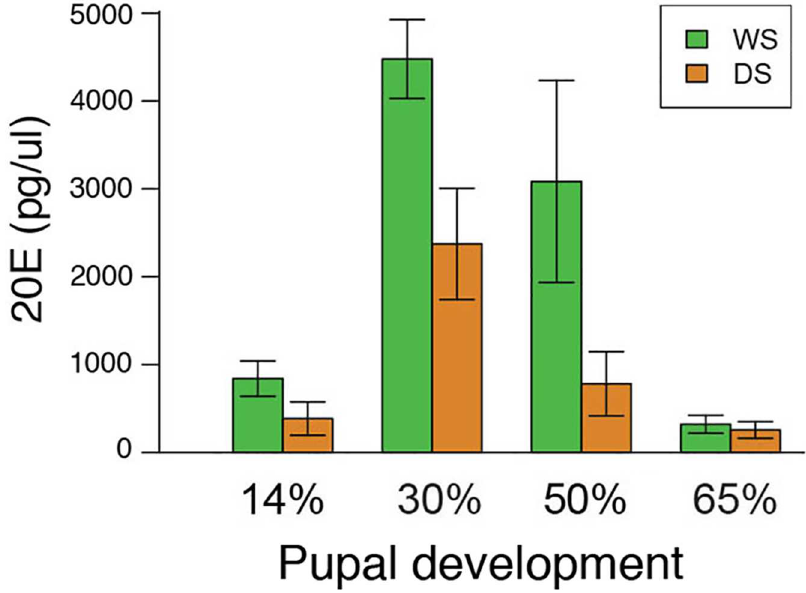
Fig 1. WS B . anynana males have higher titers of 20-hydroxyecdysone (20E) during early pupal development than DS males. T-test performed on hormone titer measurements show that there are significantdifferences in 20E titers in the hemolymphof B . anynana WS and DS male pupae at 14%, 30%, and 50% of pupal development but not at 65% pupal development. Error bars correspondto 95% confidence intervals for the